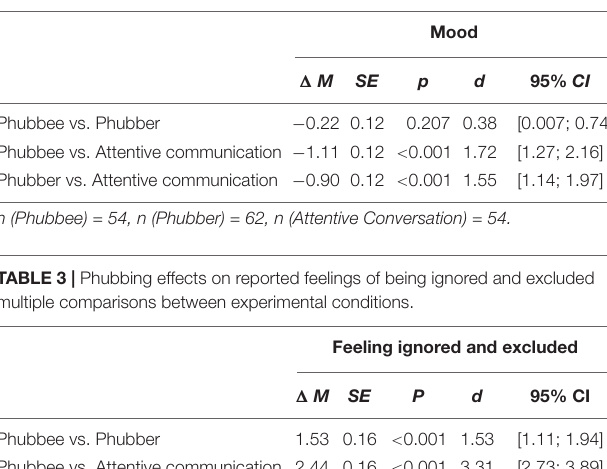
TABLE 2 | Phubbing effects on reported mood: multiple comparisons between experimental conditions.